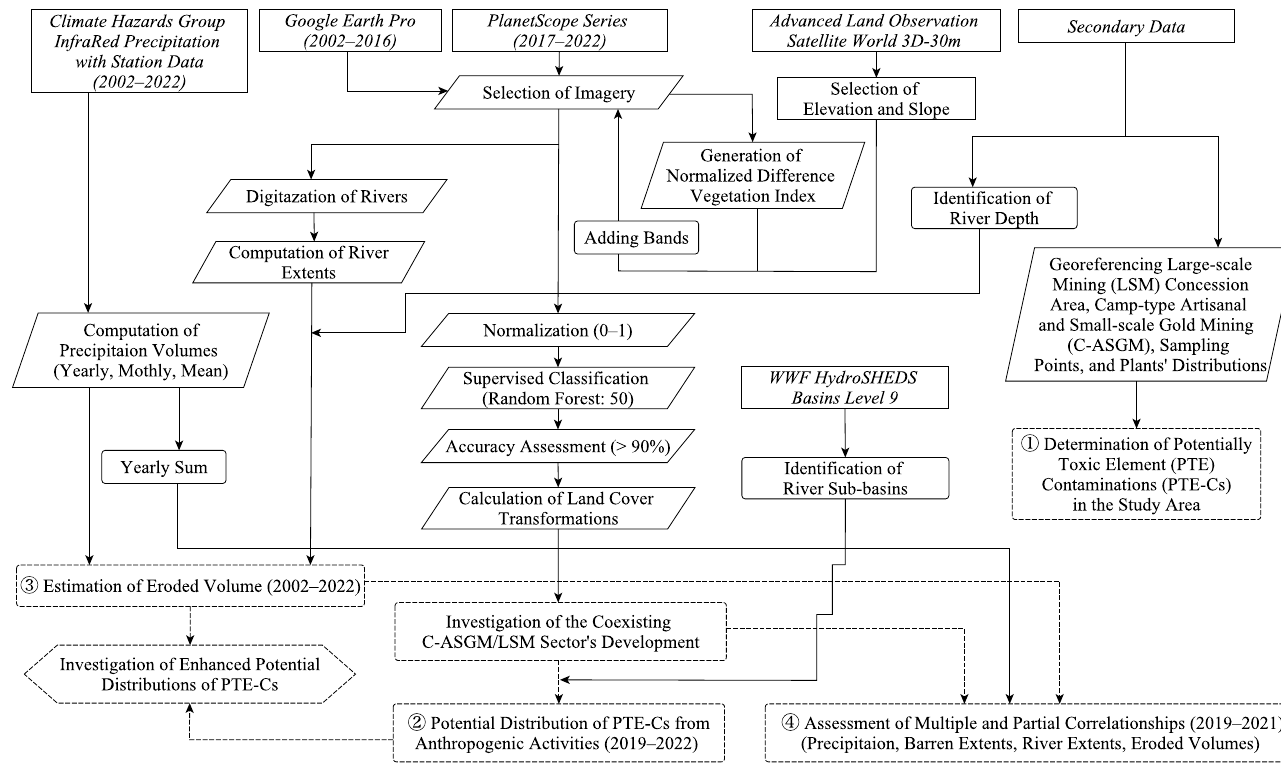
Figure 1. Overall methodological workflow used in this study.